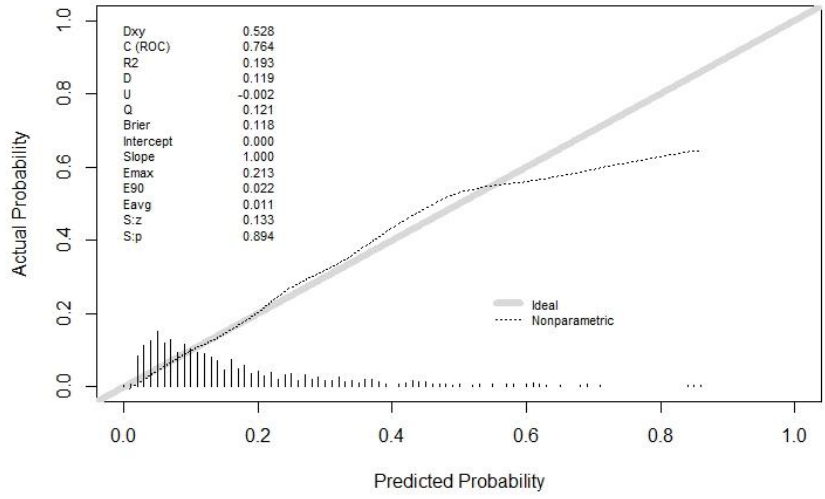
Figure 3. The calibration curve. Both the C statistic and Brier value in the figure are precalibration values. The C statistic after internal verification and adjustment was 0.727. The Brier value was 0.126 after internal validation adjustments. Both of them are acceptable.